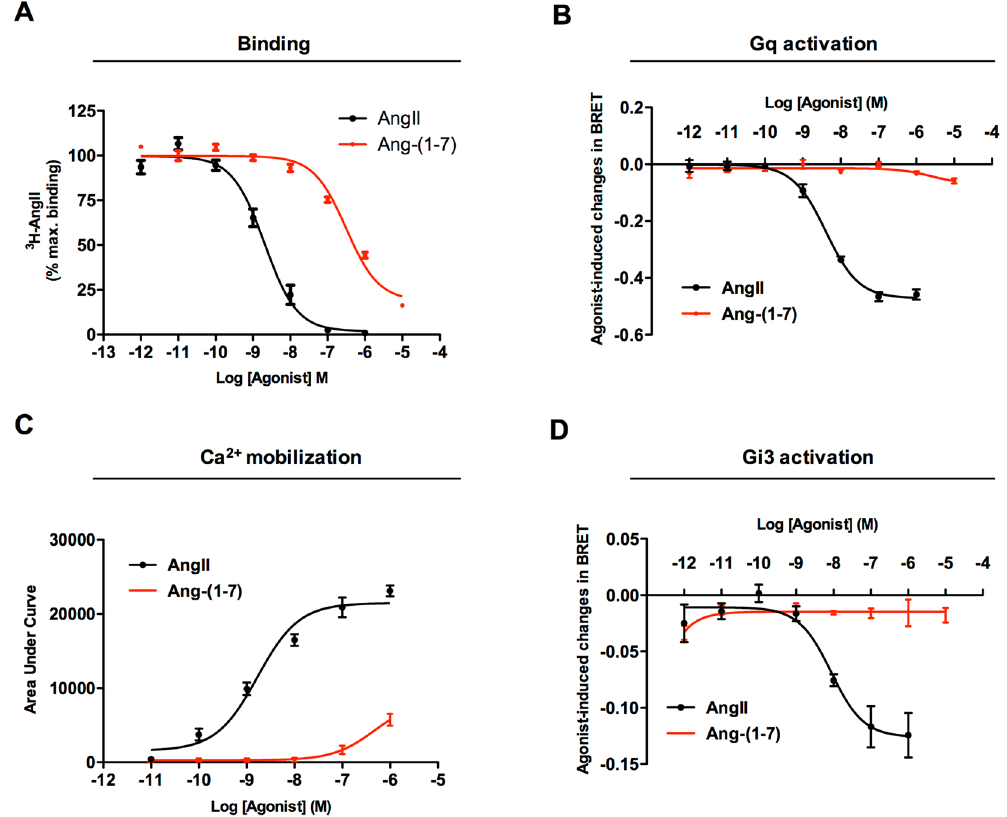
Figure 1. Comparative analyses of Ang-(1-7) and AngII acting at the AT 1 receptor: binding and analyses of G protein activation pathways. ( A ) Competition binding profiles for AngII and Ang-(1-7) against [ 3 H]AngII in HEK293T cells transiently expressing the AT1R. Data are expressed as percentages of the maximum specific binding of the radioligand. AngII and Ang-(1-7) effects on Gq activation ( B ), intracellular Ca 2 + mobilization ( C ) and Gi3 activation ( D ). All data were generated from at least 3 independent